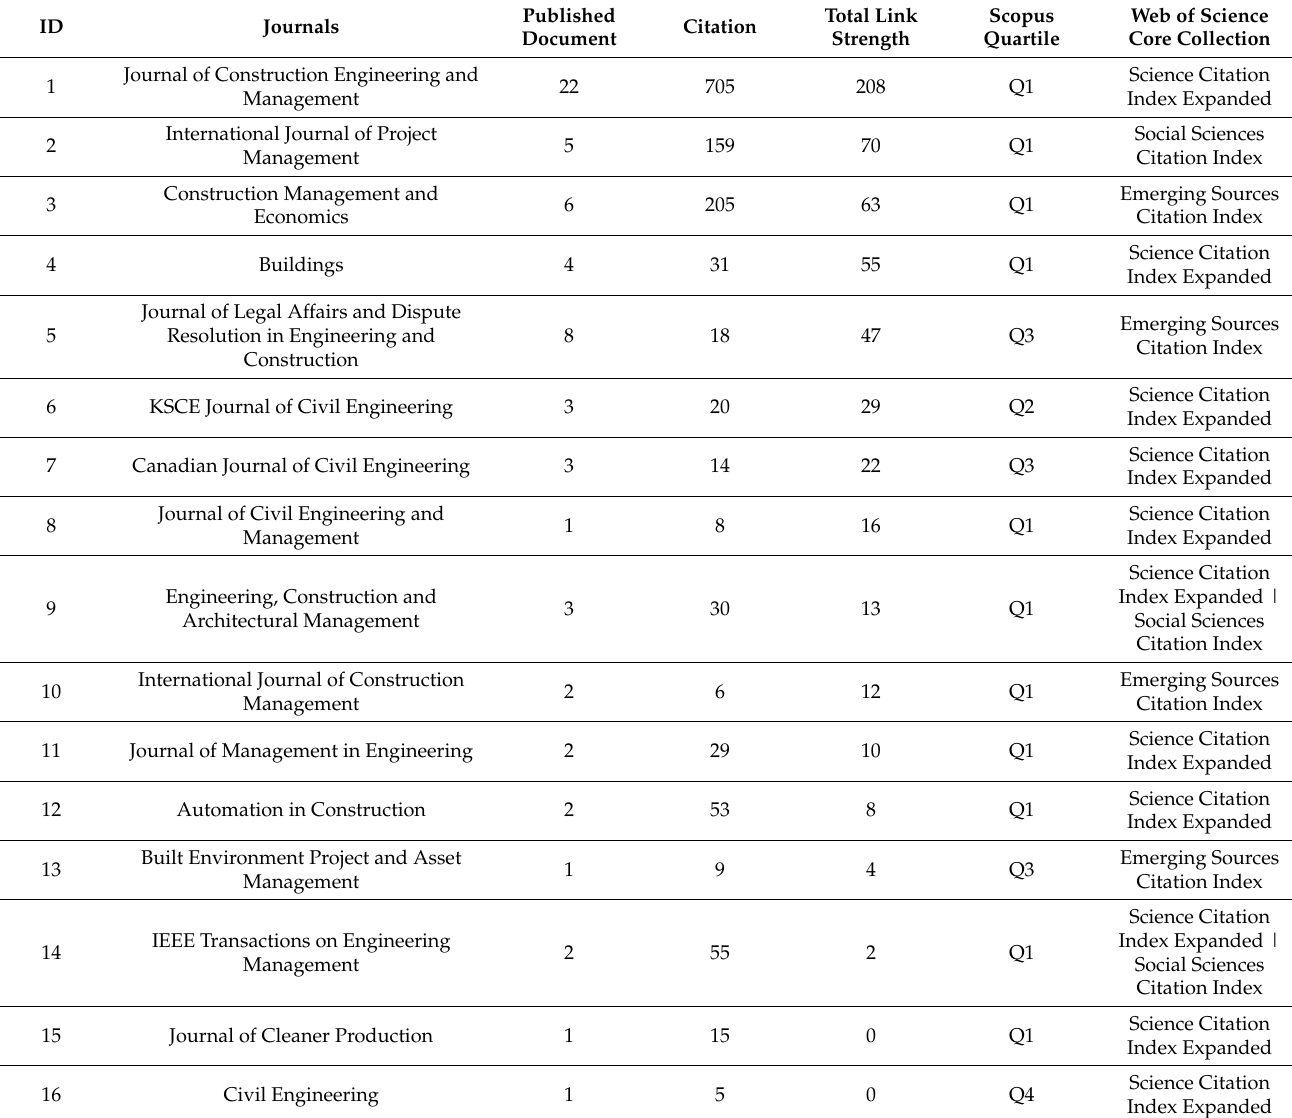
Table 3. Mapping the journals as per